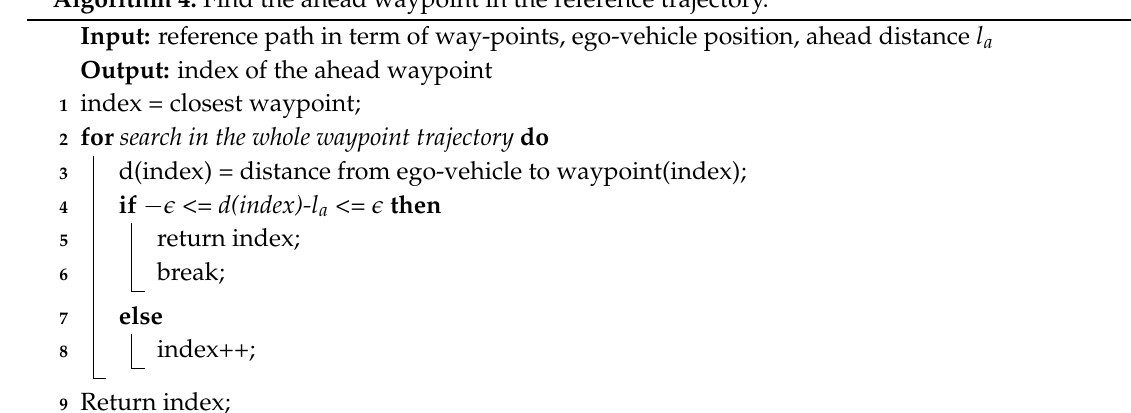
Algorithm 4: Find the ahead waypoint in the reference trajectory.